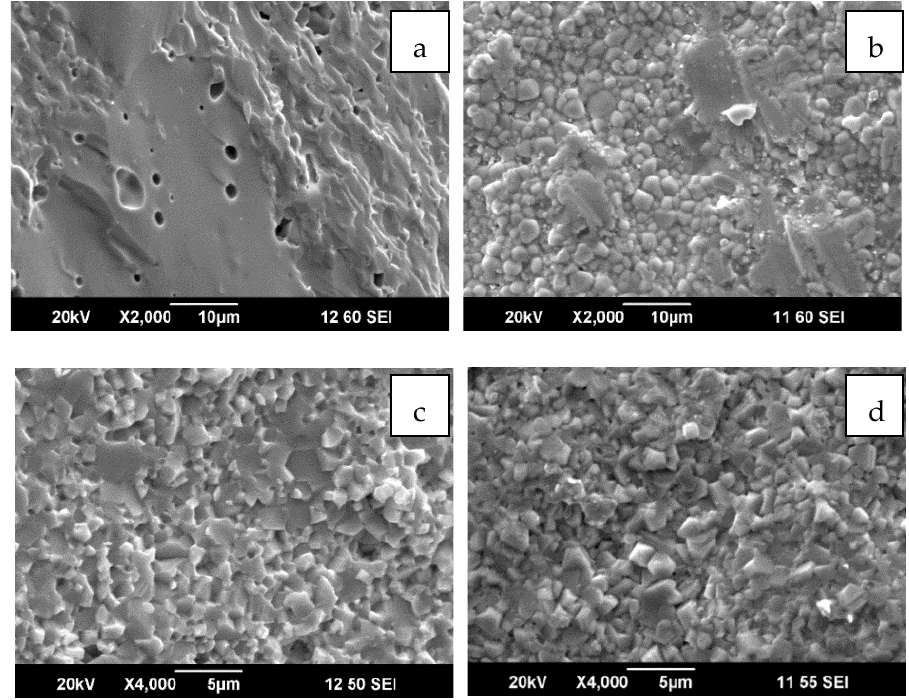
Figure 2. Microstructure of ( a , c ) a fracture surface and ( b , d ) the outer surface of the ( a , b ) La 2 Hf 2 O 7 and ( c , d ) La 2 (Hf 1.9 La 0.1 )O 6.95 ceramics.